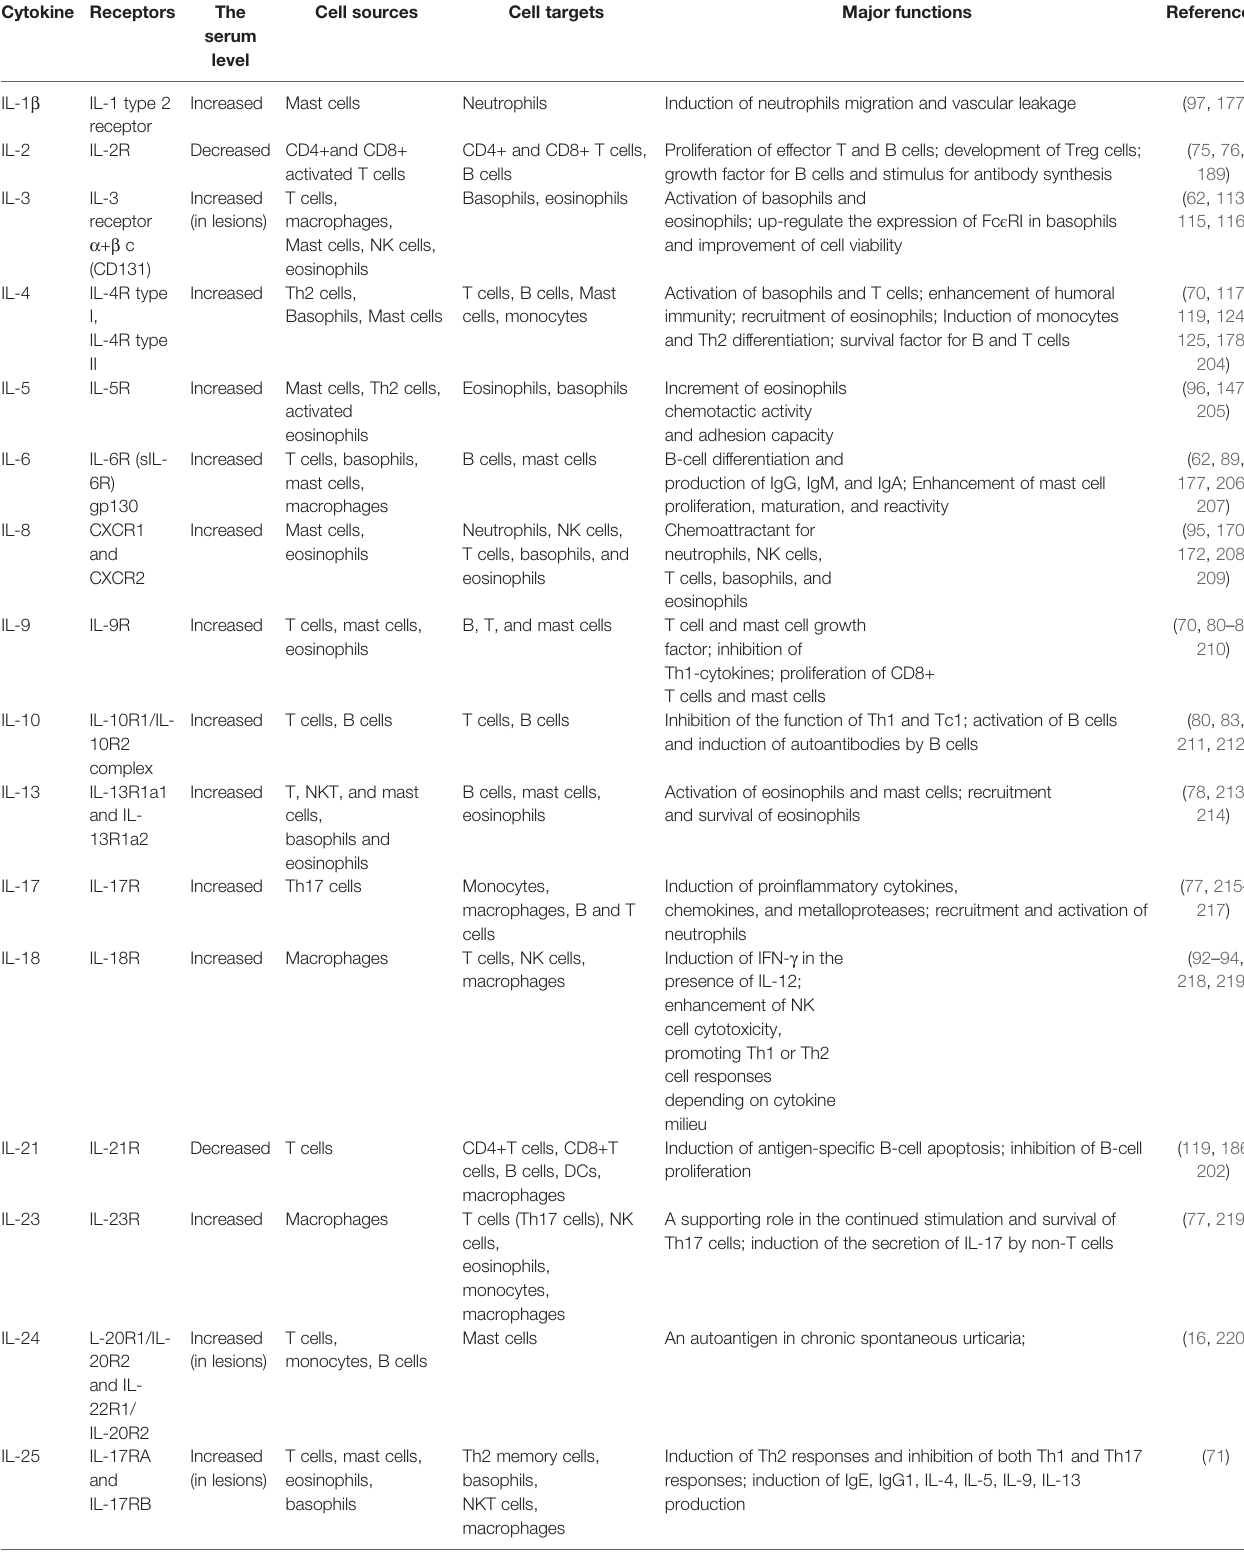
TABLE 2 | Possible crosstalk pathways between immune cells involved in